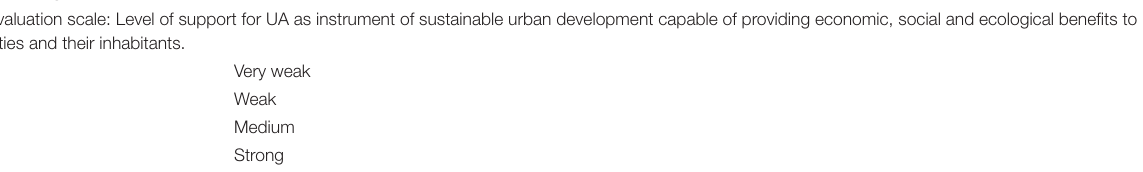
Evaluation scale: Level of support for UA as instrument of sustainable urban development capable of providing economic, social and ecological benefits to cities and their